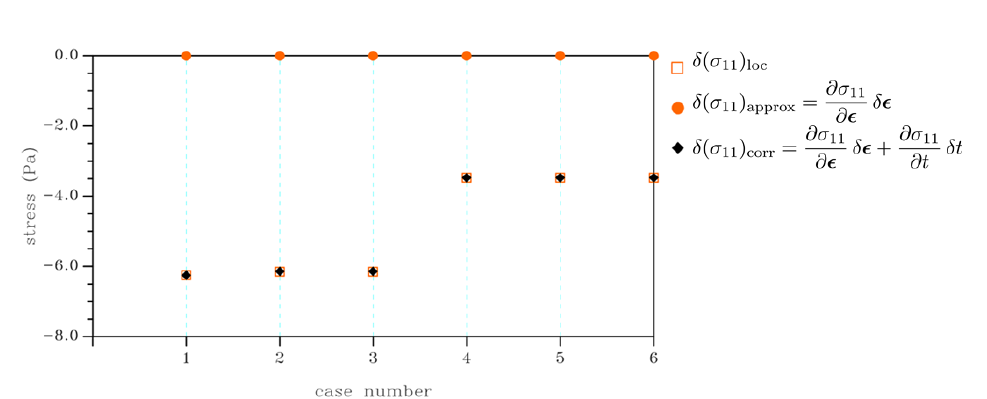
Figure 8. Validation tests. Stress increments δ ( σ 11 ) i starting from σ n + 1 = p 0 m + ∆ σ for numerically infinitesimal strain increments δ ( (cid:101) i ) with i = 1,2, . . . ,6. Table 2. Stress increments in Pa during Validation Test 4 (case n 2 = [ 000100 ] T ). δ ( σ loc ) δ (cid:0) σ approx (cid:1) δ ( σ corr ) δσ